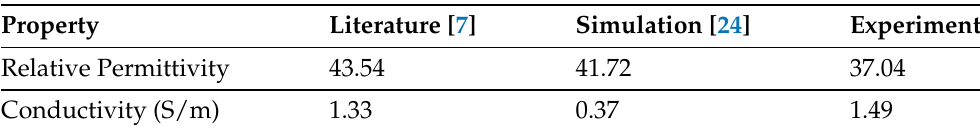
Figure 5. Double-layered simulation configuration and 2.2 mm-diameter probe design: ( a ) first layer represents the skin tissue with d 1 thickness and the second layer represents the liquid (olive oil or triton X-100) with d 2 thickness. ( b ) Simulated open-ended coaxial probe with 2.2 mm outer diameter and 0.657 mm inner diameter. Table 2. Comparison of the literature data, simulation, and experiment results for skin mimicking phantom at 2